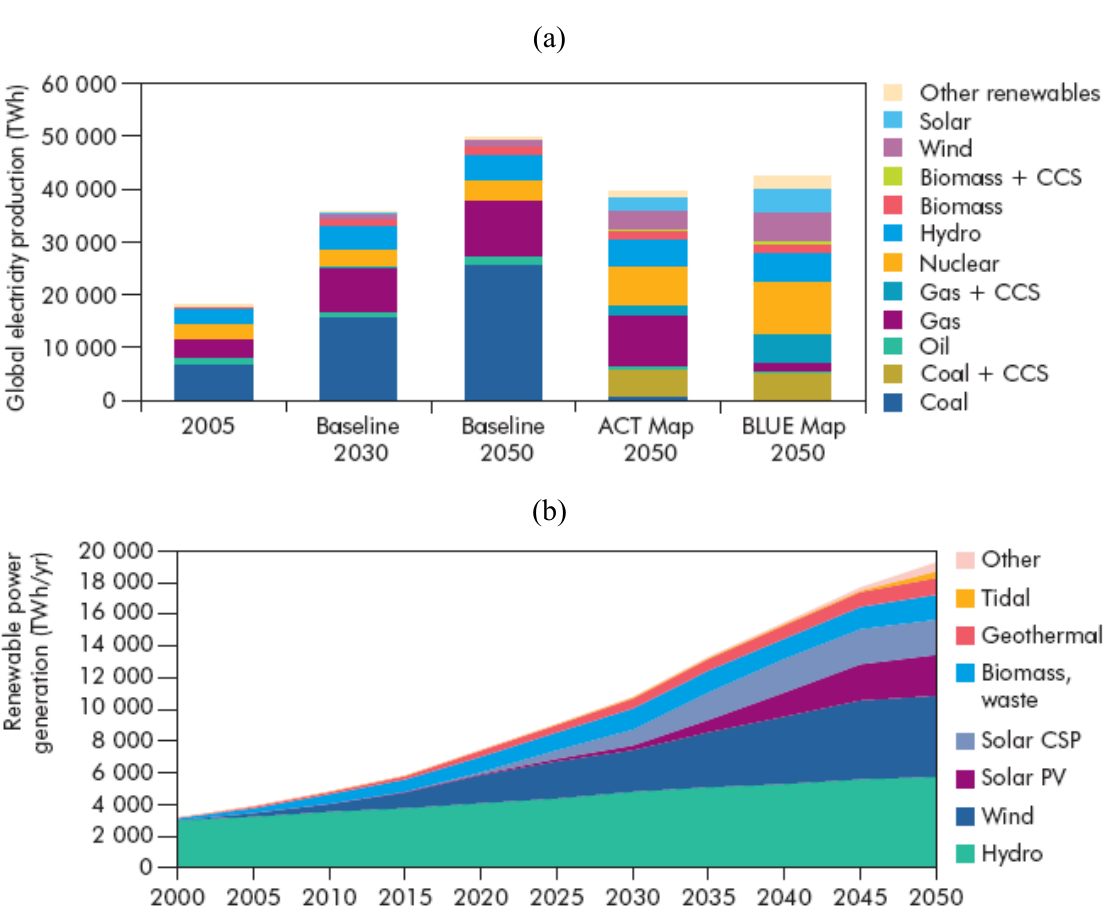
Figure 8. (a) Electricity generation in the IEA ACT and BLUE scenarios. (b) Renewable electricity generation in the IEA BLUE scenarios. © 2008 OECD/IEA, reproduced from [2] with permission.